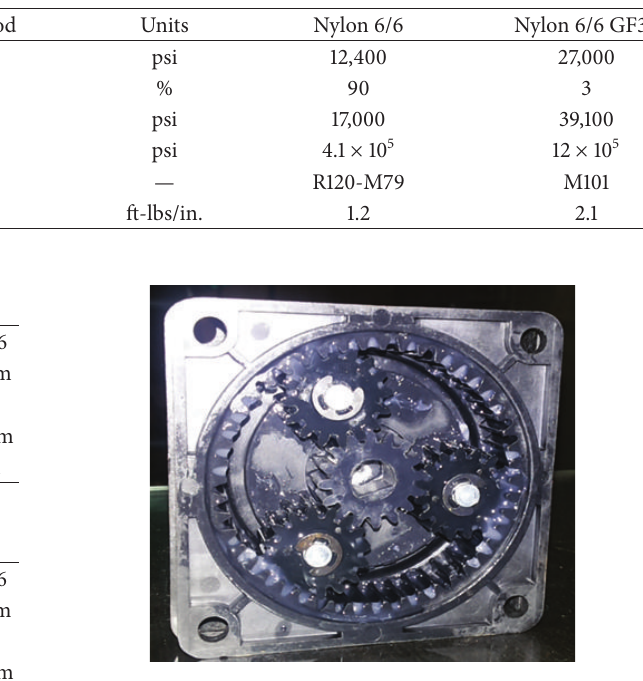
Figure 4: Planetary gear